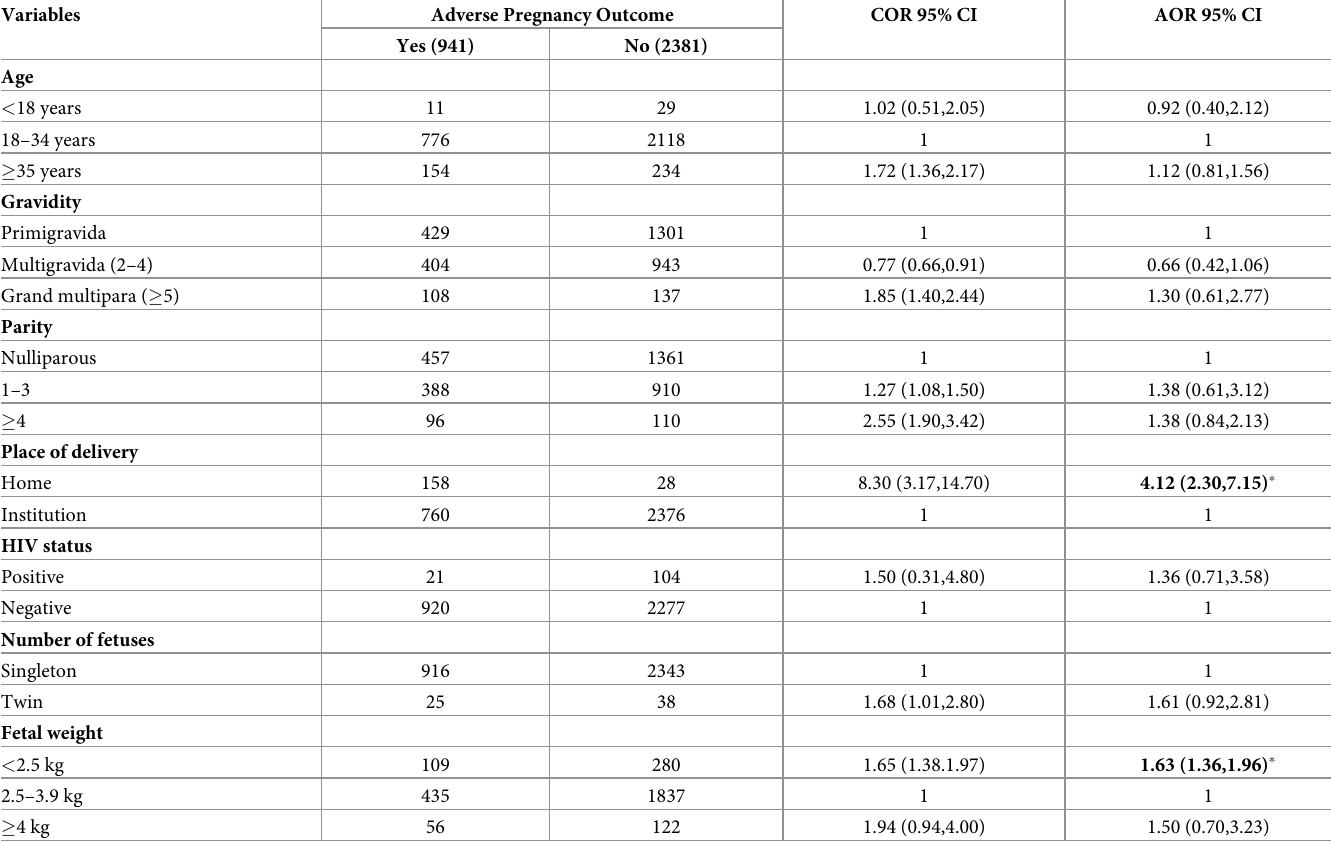
Table 2. Independent predictors of adverse pregnancy outcome in mothers attending obstetric care at Debre Berhan Comprehensive Specialized Hospital, North- east Ethiopia.